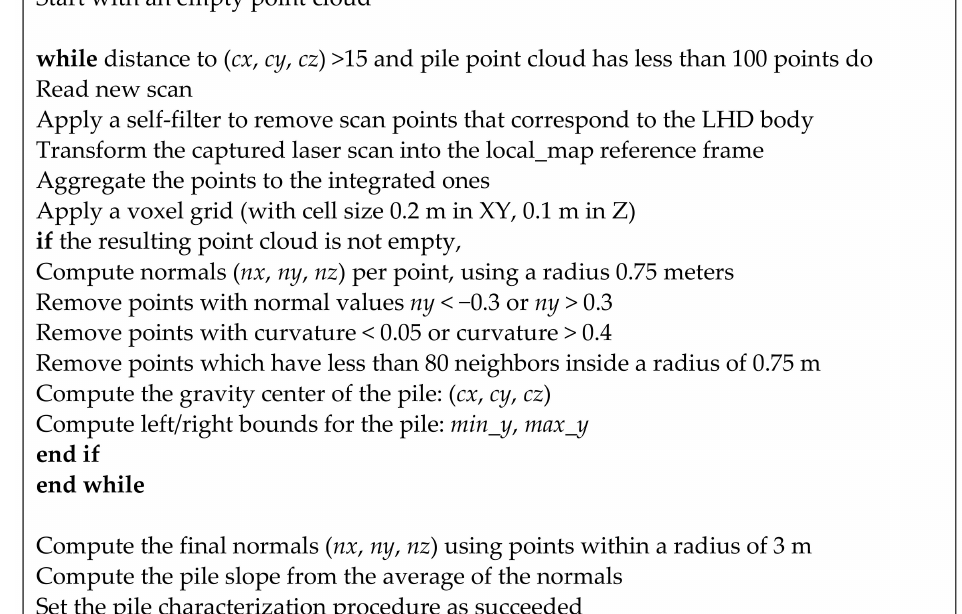
Figure 9. Pseudo code of pile segmentation and characterization algorithm.